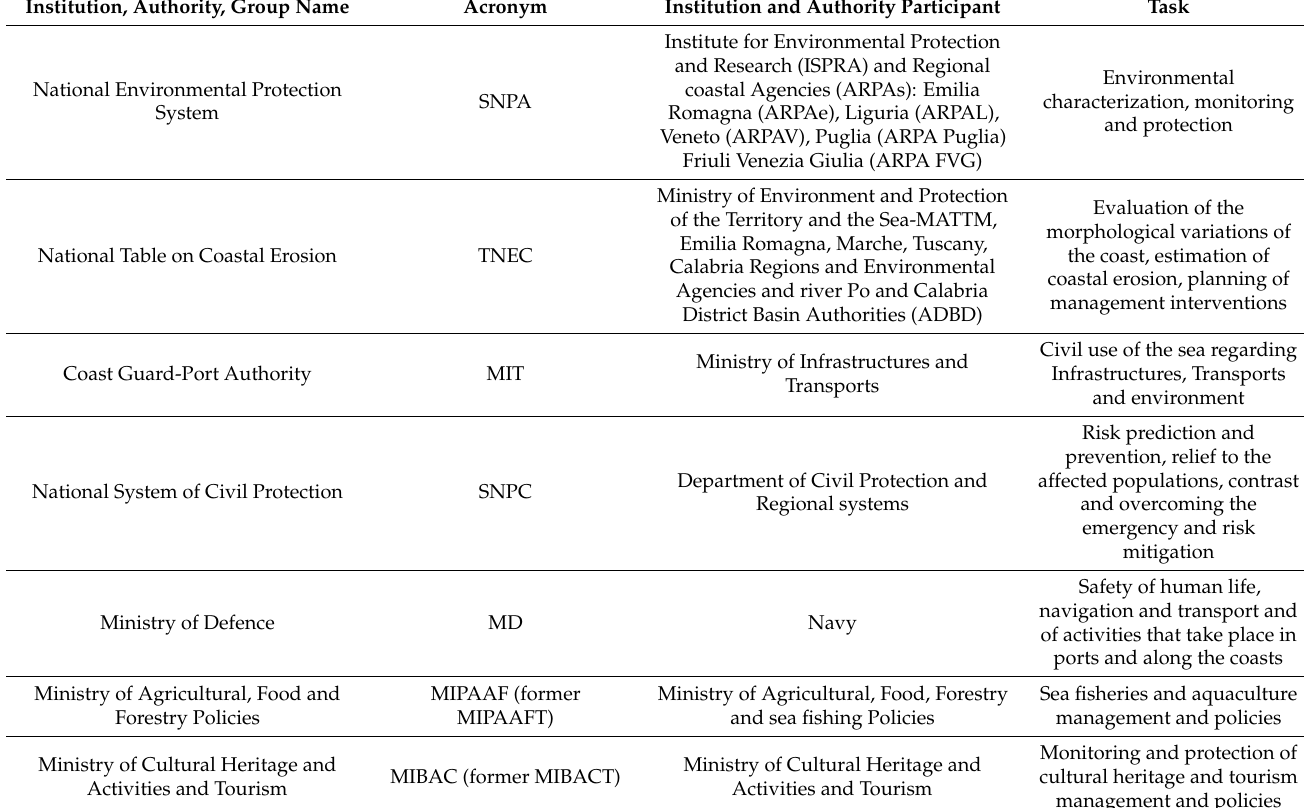
Table 1. Institutional coastal users involved in the consultation and their tasks in relation to coastal